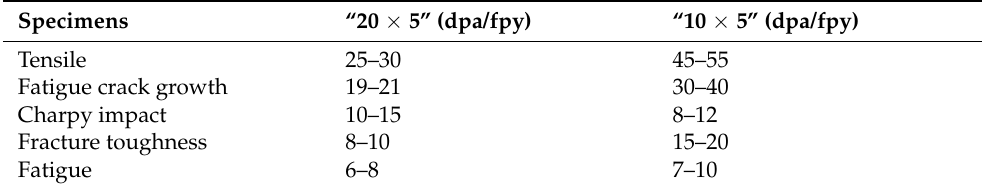
Figure 12. The specimen arrangements for BP with two footprints. The pink area represents the actual size of the BP high-DPA region, the dark-blue lines are the DPA contours, and the specimens are shown in the same dimension scale as the BP. The Z coordinate value given on the right size indicates the vertical positions that allow for different types of specimens based on their thicknesses. ( a ) “20 × 5”; ( b ) “10 × 5”. Table 2. Reachable DPA (dpa/fpy) for the specimens based on the arrangement shown in Figure 12.